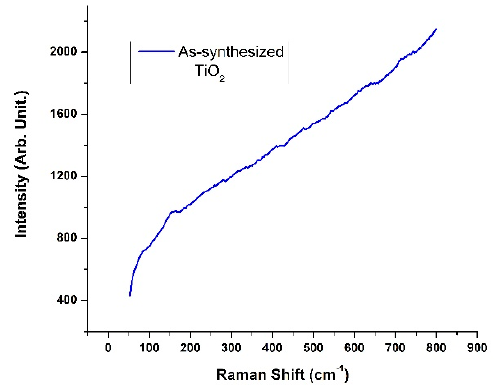
Figure 1. Raman spectra for as-synthesized TiO 2 powders.